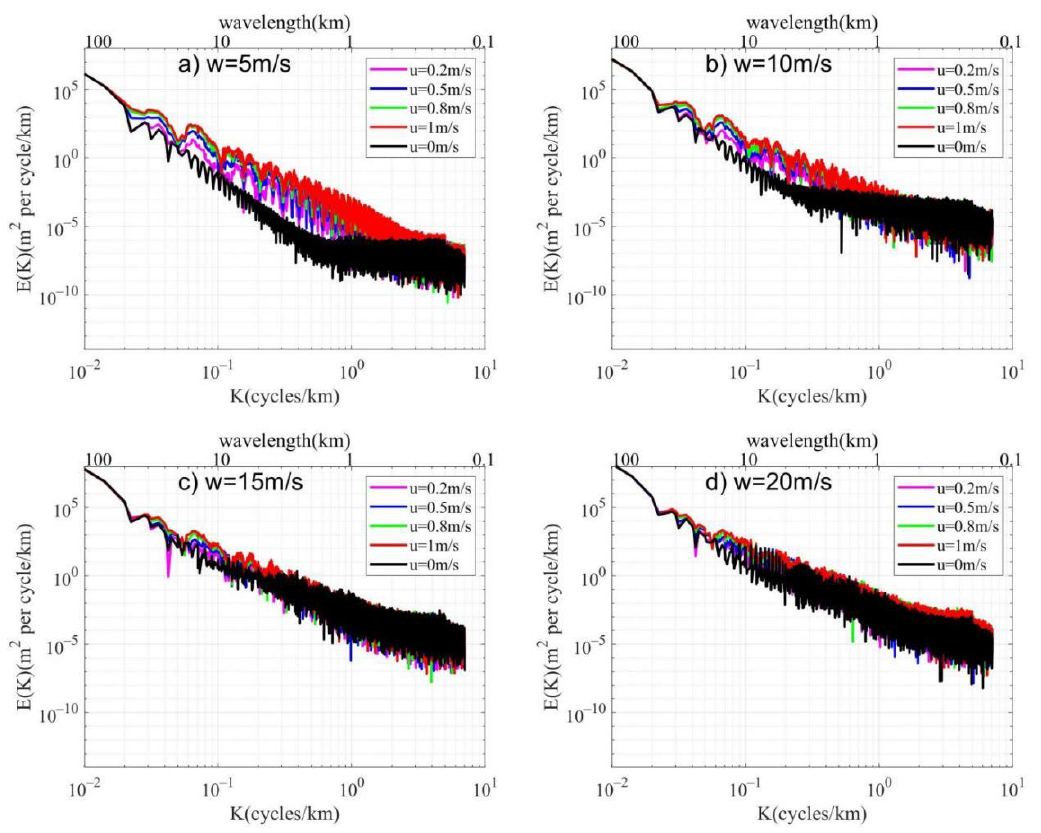
Figure 9. 1D spectra of significant wave heights (H s ) under wind speeds of ( a ) 5 m/s, ( b ) 10 m/s, ( c ) 15 m/s, and ( d ) 20 m/s with without currents (black lines) and with current velocities of 0.2 (magenta), 0.5 (blue), 0.8 (green), and 1 m/s (red), respectively.